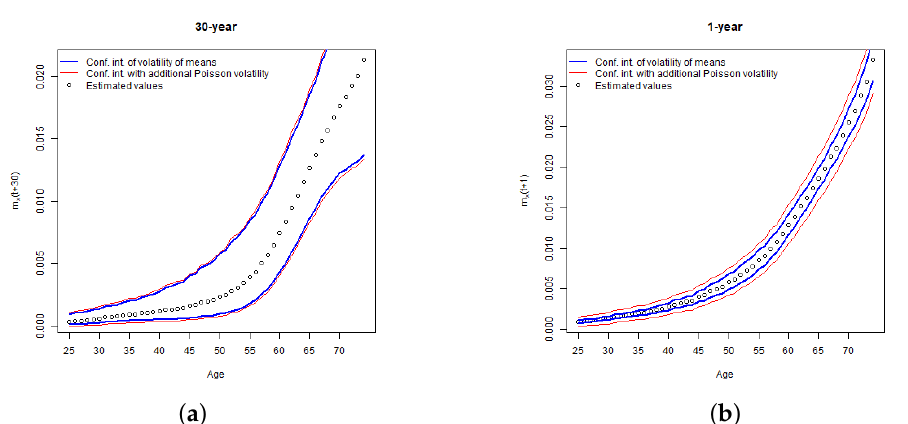
Figure 7. Confidence intervals for 30-year projection ( a ) and 1-year projection ( b ) of mortality rates with and without taking into account the additional volatility from random fluctuation around the modelled mean mortality rates. The calculations were performed for Lithuanian data by assuming Gaussian approximation of Poisson distribution and by allowing for